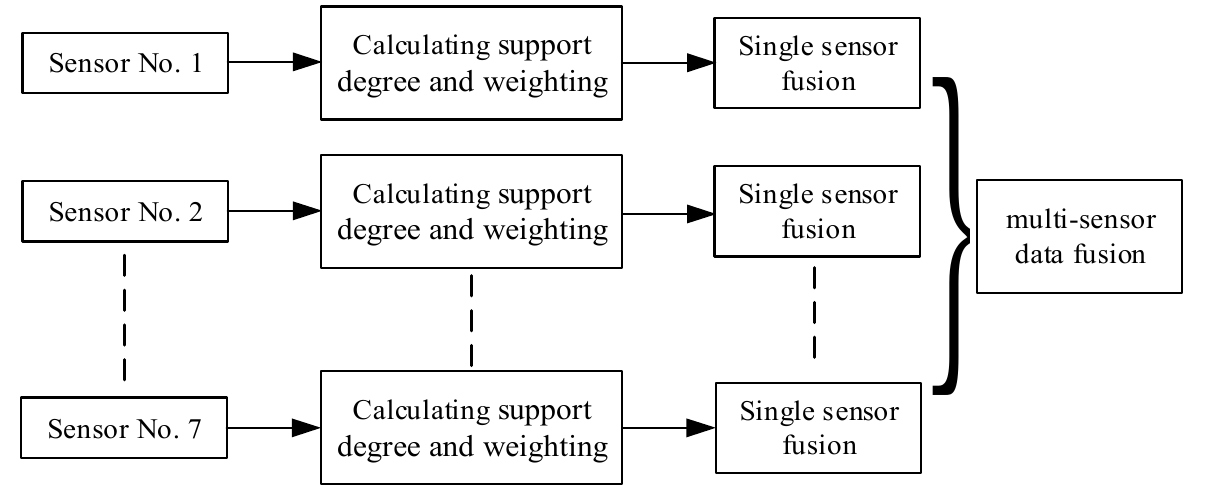
Figure 3. Structural framework of sensor array data fusion.